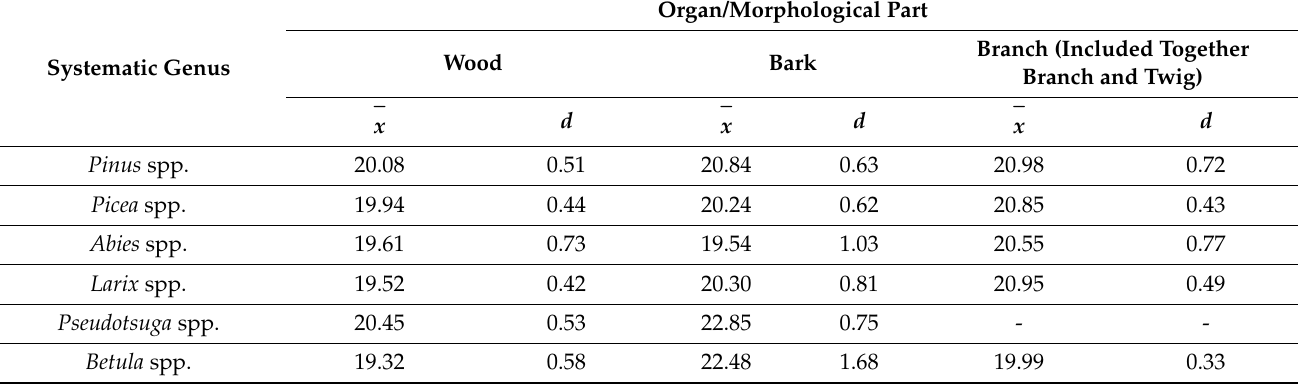
Table A10. Average value and average deviation of the HHV (MJ kg − 1 d.m.) of various organs of particular systematic genera